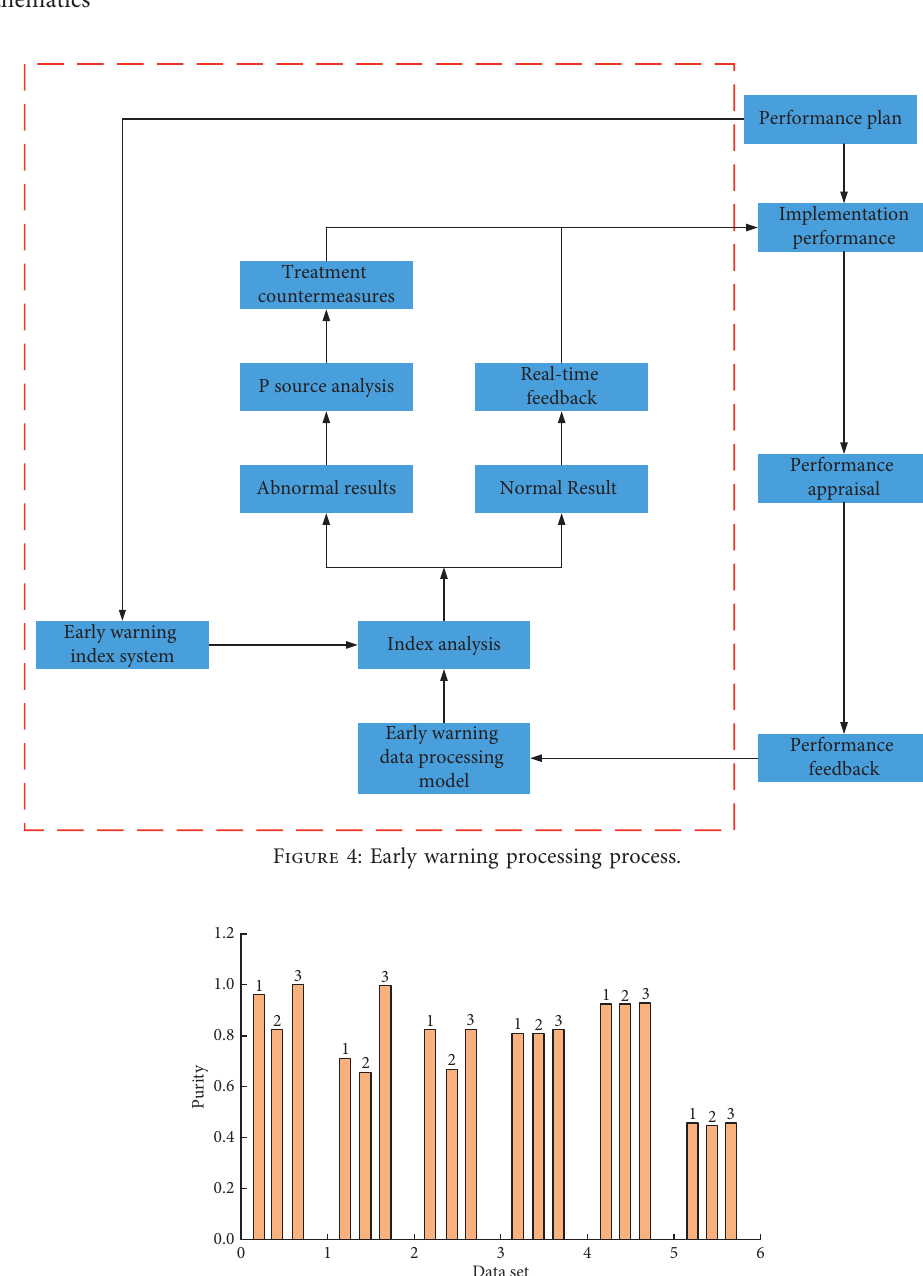
Figure 5: Comparison of purity of three